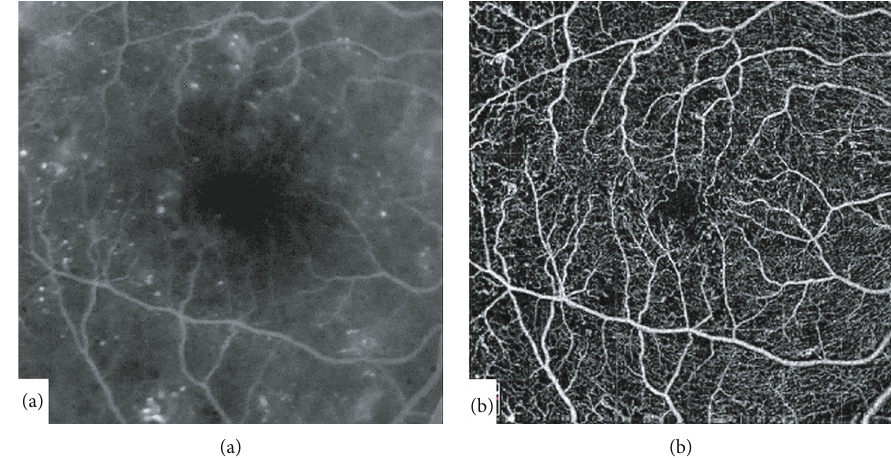
Figure 2: Compared to fl uorescein angiography (a), optical coherence tomography angiography (Optovue, Inc., Fremont, CA, USA) of the macula (b) allows imaging of the retinal capillaries and foveal avascular zone in high resolution without obscuration by dye leakage or macular xanthophyll pigment